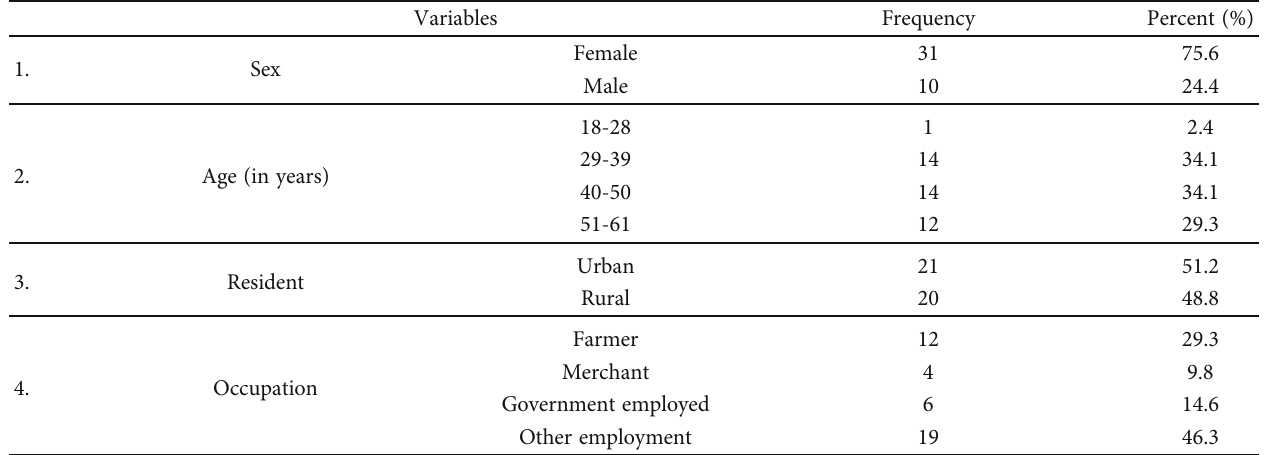
Table 1: Sociodemographic characteristics of the study